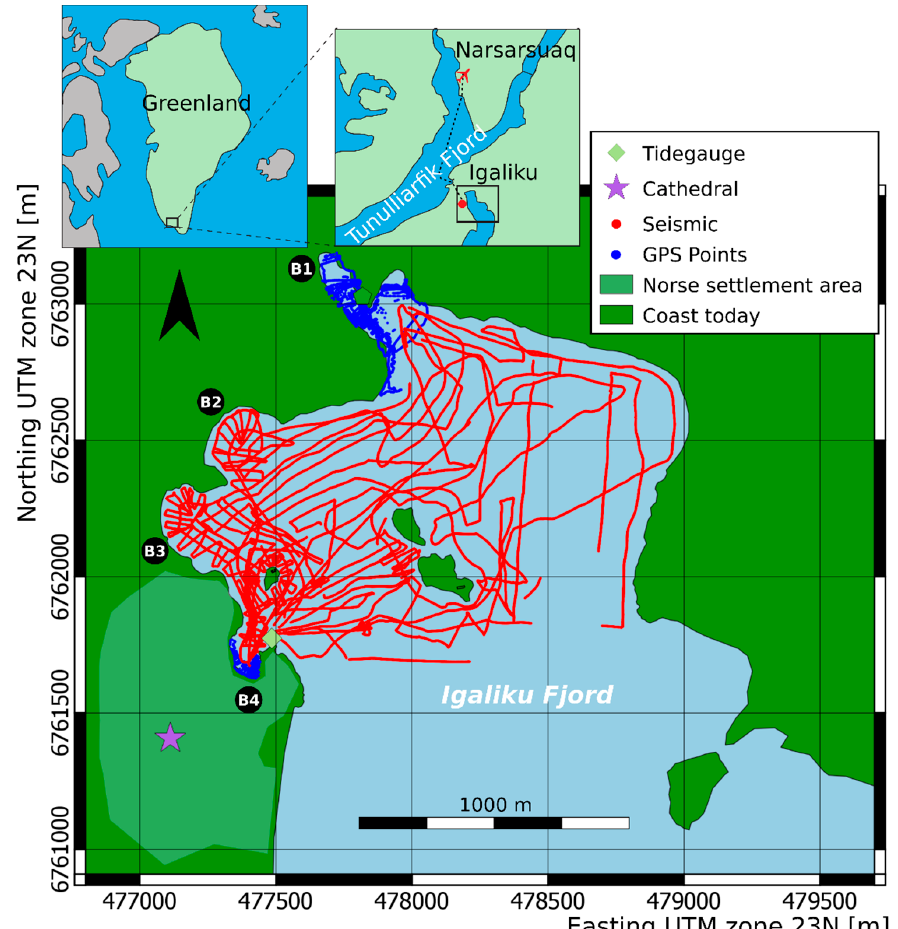
Figure 1. Map of the investigation area including the area of the former Norse settlement, the positions of the cathedral and former bishop’s seat, and the stone buildings that were possibly connected with trading activities. Seismic and side-scan lines are marked red, and GPS height measurements are marked blue. B1–B4 mark the four embayments of the survey area.